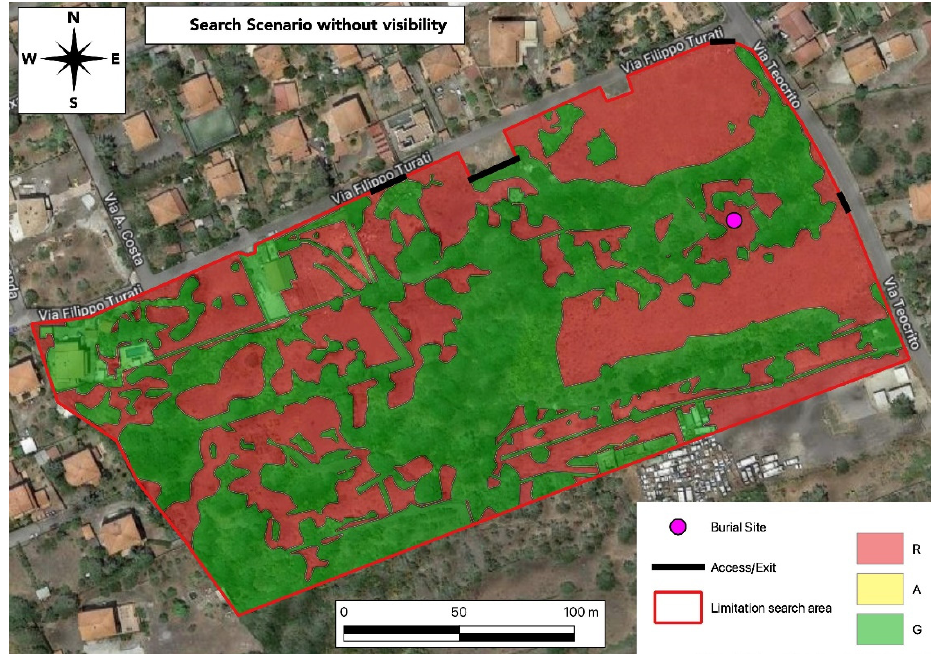
Figure 22. RAG map of the “Search scenario without visibility” (for night concealments) of the GIS platform. The burial site fell on the Red coded area. For the percentages of RAG color-coded areas see Figure 20 (the Amber-coded area is not visible covering the 6% along the Red and Green area boundary).